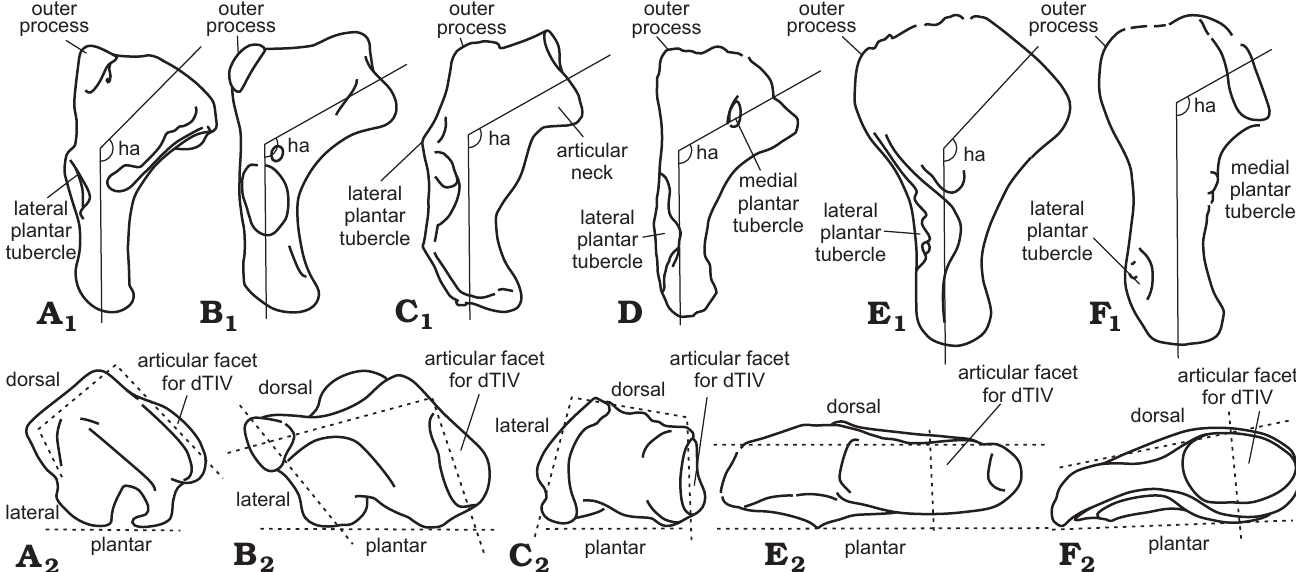
(1981).Fig. 1. Comparison of the fifth metatarsal architecture. Left bones in plantar view demonstrate hooking and articular facet orientation (A 1 –C 1 , D, E 1 , F 1 ) and in proximal view (plantar surface down) (A 2 –C 2 , F 2 ). A . Iguana iguana (Linnaeus, 1758), Iguanidae, Recent. B . Sphenodon punctatus (Gray, 1842), Rhynchocephalia, Recent. C . Sophineta cracoviensis Evans and Borsuk-Bia ł ynicka, 2009, Lepidosauromorpha, Early Triassic, Poland. D . Gephyrosaurus bridensis Evans, 1980, Rhynchocephalia, Early Jurassic, South Wales, UK (right MttV reversed). E . Osmolskina czatkowicensis Borsuk-Bia ł ynicka and Evans, 2003, Archosauriformes, Early Triassic, Poland. F . Morphotype X, Early Triassic, Poland . The dashed lines approximate the outlines of the fifth metatarsals as seen in proximal view (for additional explanation see Material and methods). ha, hooking angle. Not to scale. A, B 1 , C, after Robinson (1975); D, after Evans